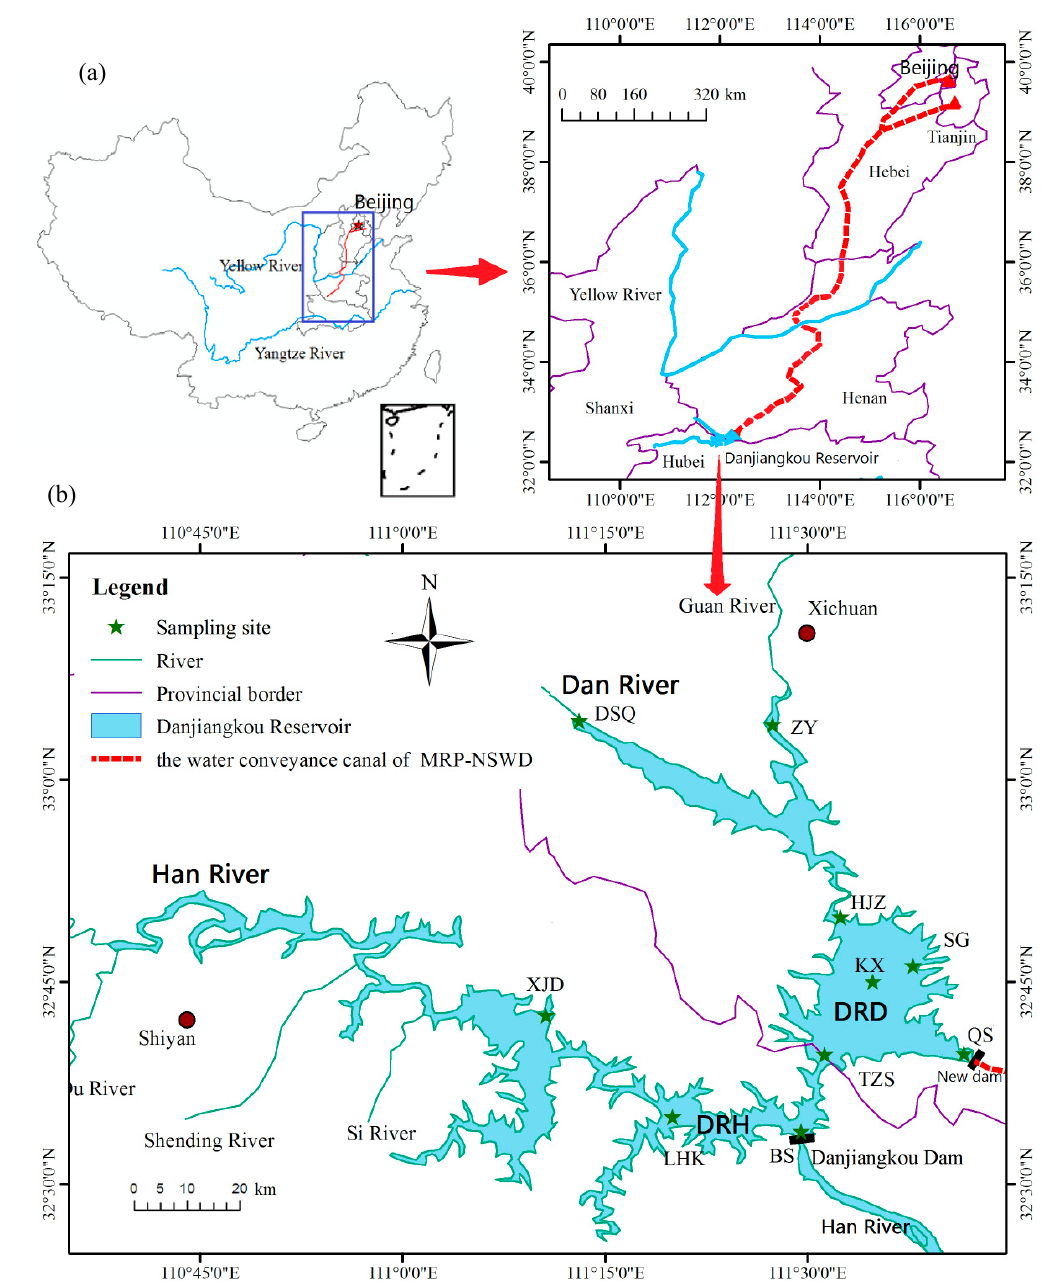
Figure 1. Map of China showing ( a ) water diversion route from the reservoir to the destination cities (Beijing and Tianjin); and ( b ) sampling sites in the Danjiangkou Reservoir. The map was generated using ArcGIS 10.0 (ESRI, Redlands, CA, USA: http://www.esri.com/software/arcgis).